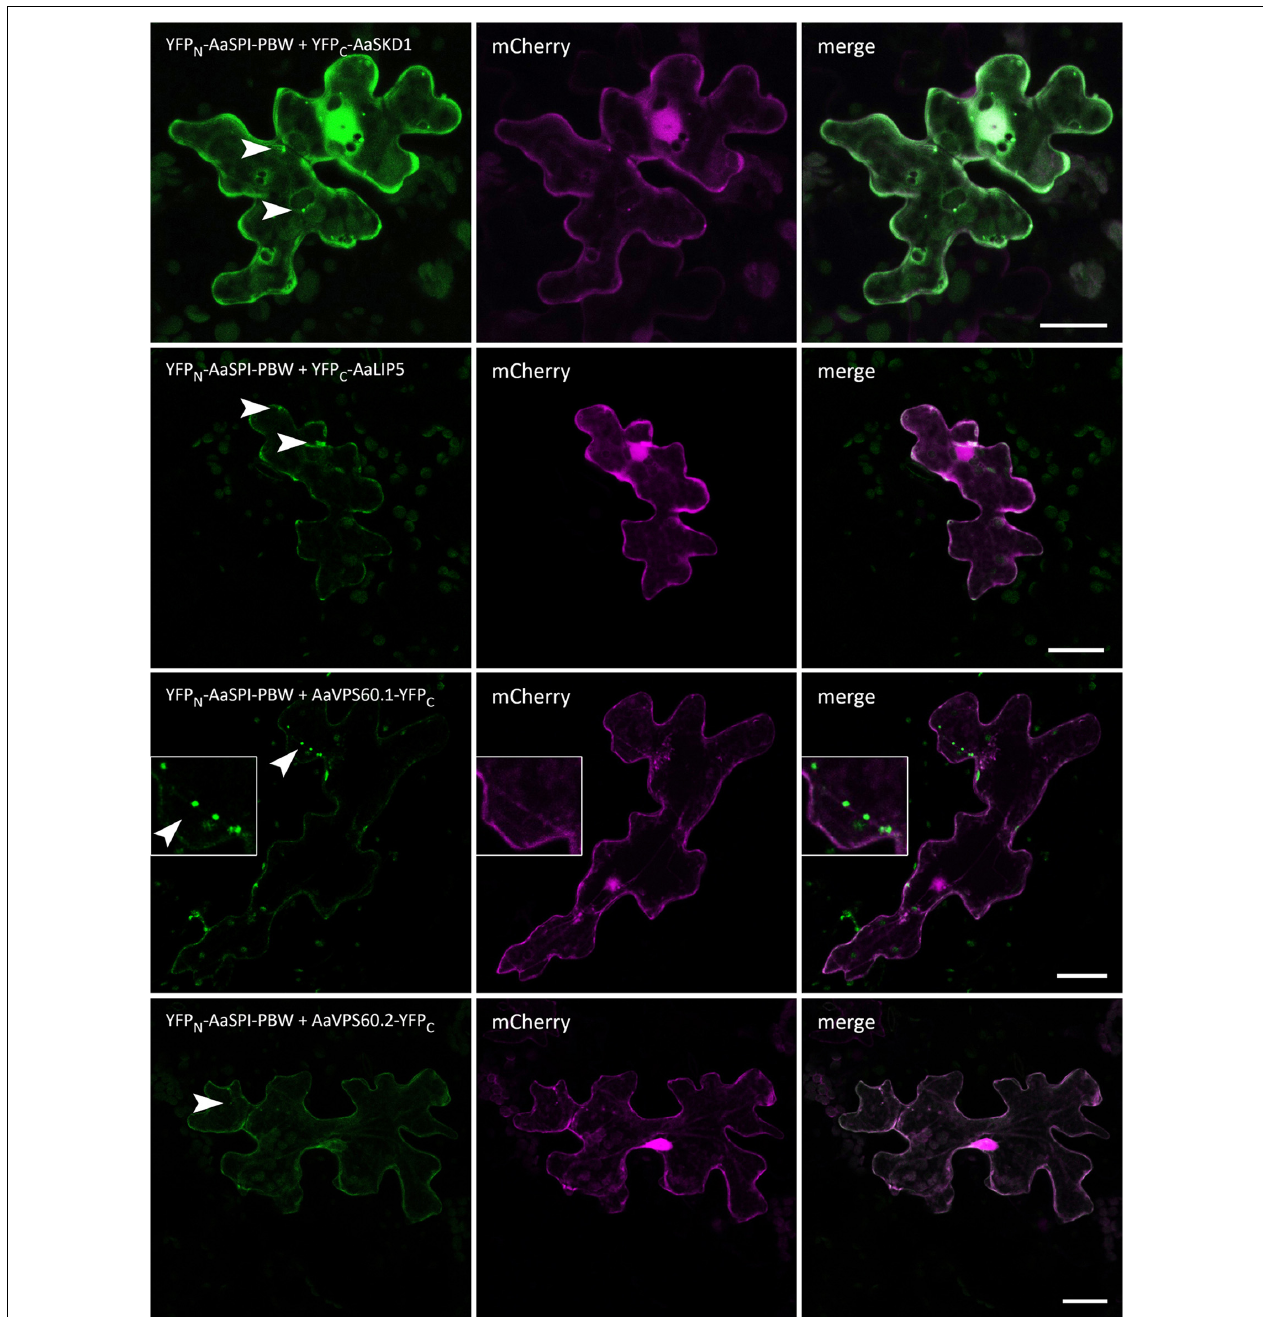
FIGURE 5 | BiFC interactions of AaSPI-PBW with ESCRT components AaSKD1, AaLIP5, AaVPS60.1, and AaVPS60.2. Left—BiFC, middle—transformation control, right—overlay of BiFC and transformation control. Arrow heads indicate the sites of interaction. Scales bars: 25 µ m.